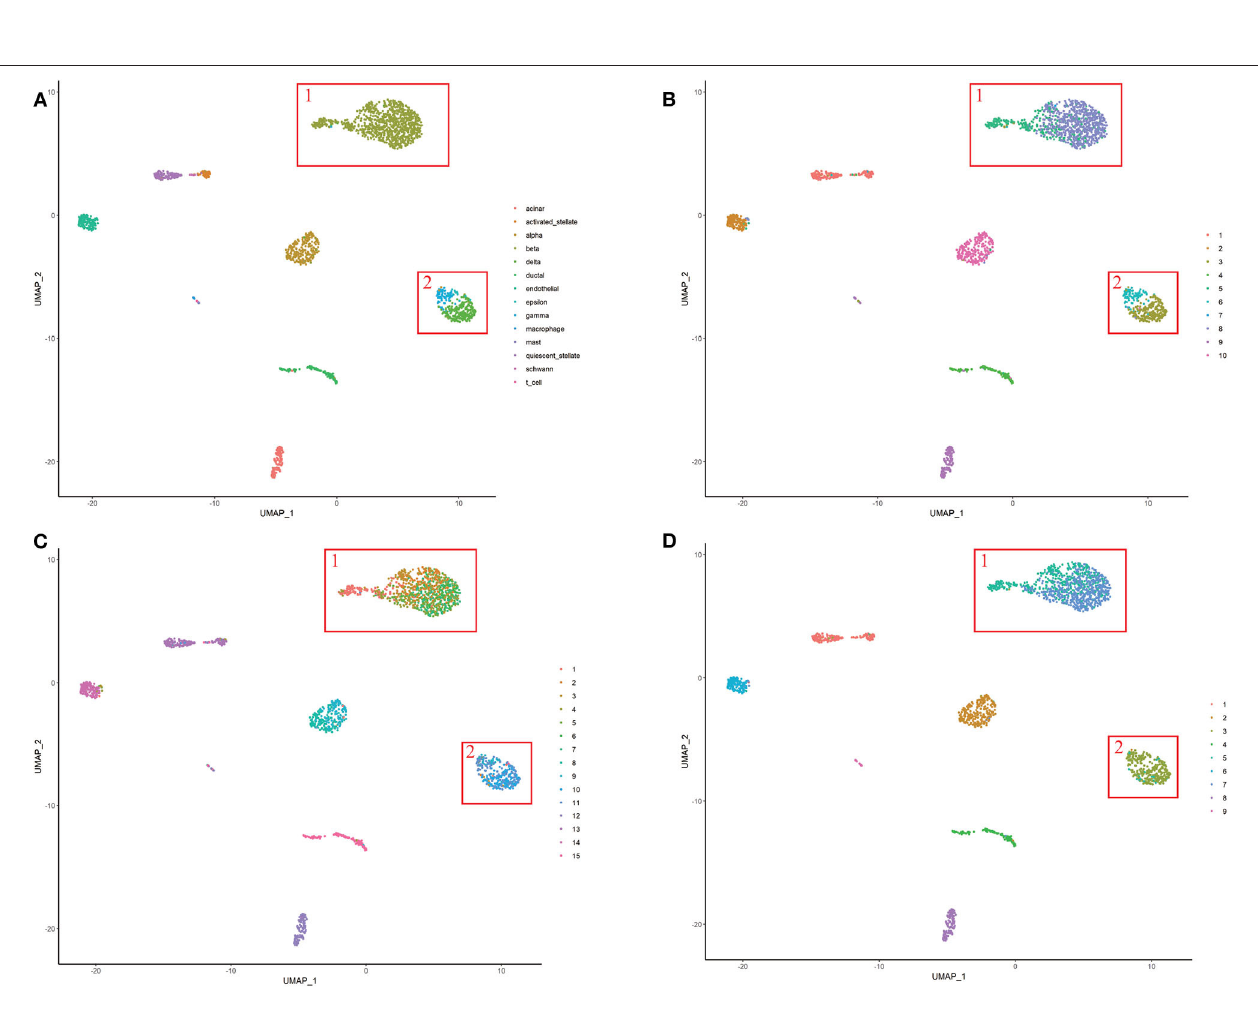
FIGURE 8 | The visualization of performance of different methods on Baron-human1. (A) True label. (B) EC-PGMGR. (C) SAFE. (D) SAME.